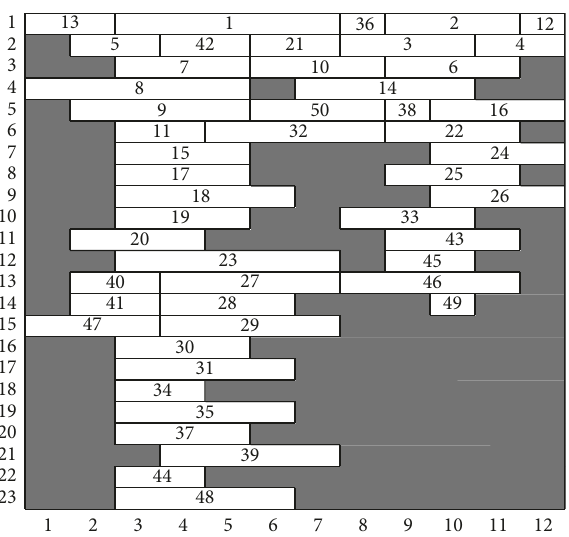
Figure 11: Utilization rate of lot 1 of the three modes.